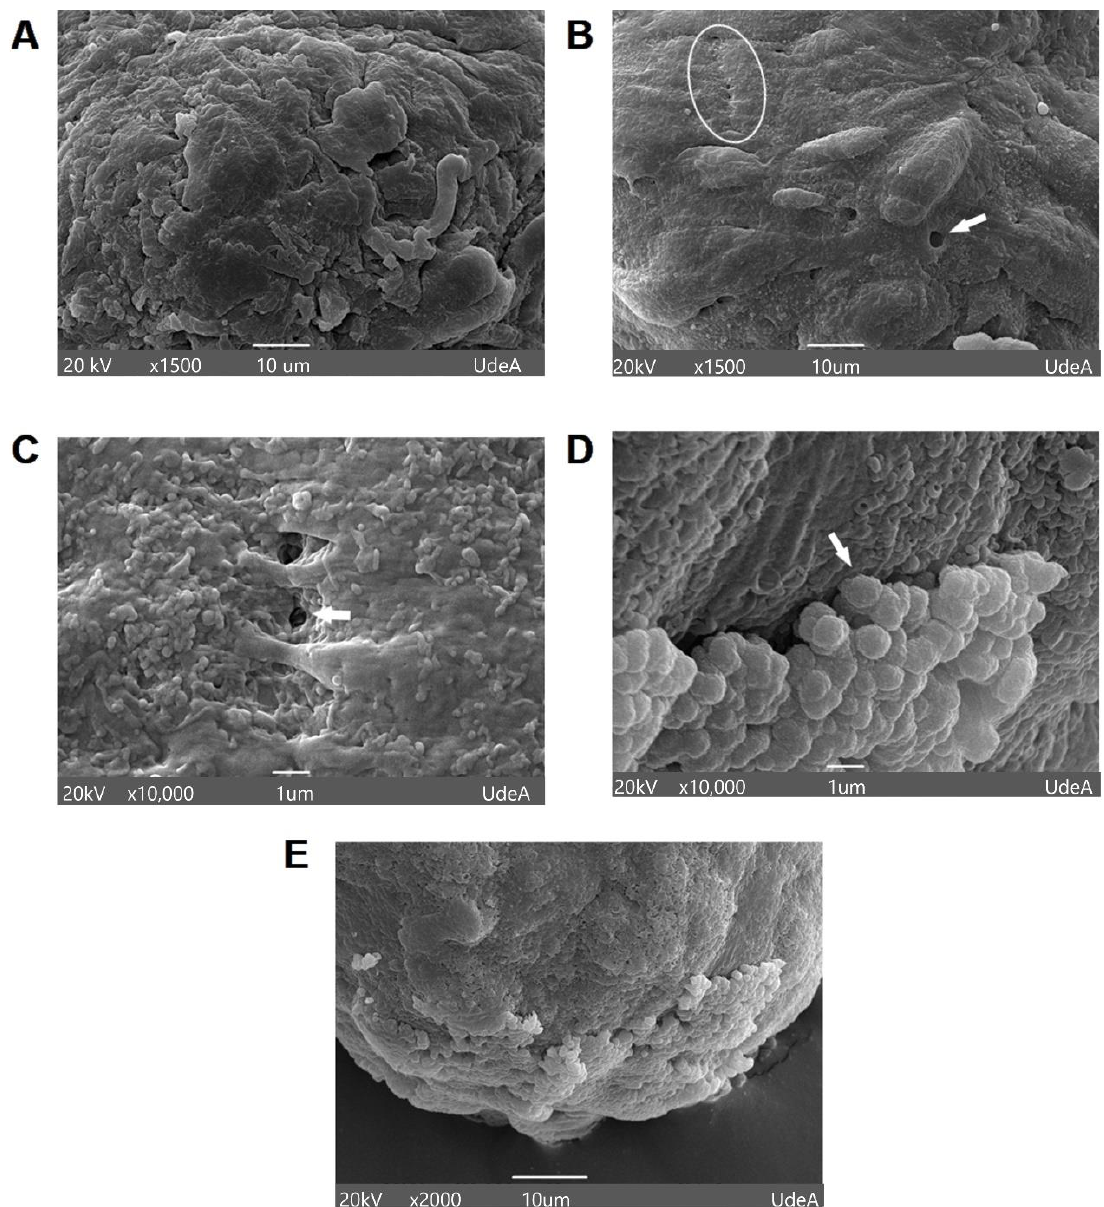
Figure 3. Morphological and topographic analysis of the surface of hGF spheroids. ( A ) Scanning electron microscope microphotographs of a young spheroid after 3 days of culture with a round but irregular surface. ( B , C ) The presence of close cell – cell interactions (white circle) and multiple pores in a mature spheroid after 9 days of culture (white arrow). ( D ) The presence of multiple spherical nanoparticles on the surface of the spheroids is indicated by the white arrow (9 days of culture). ( E ) Higher magnification shows spherical nanoparticles with a rough appearance.